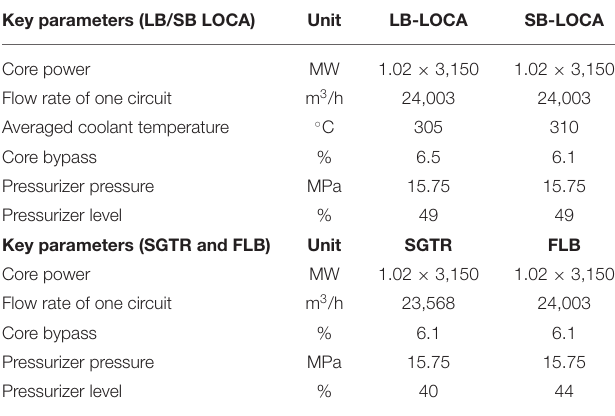
TABLE 3 | Key parameters of initial conditions of ATHLET 3.1